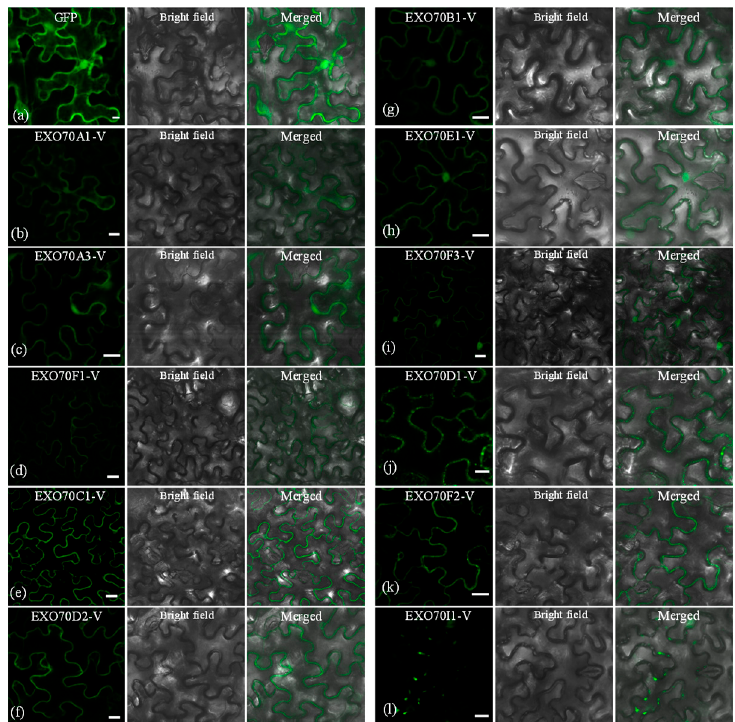
Figure 7. Subcellular localization of H. villosa EXO70-GFP-Vs proteins. H. villosa EXO70-GFP-Vs proteins were transiently expressed in N. benthamiana leaves carried out with injection of Agrobacterium and examined by a confocal microscope. Green fluorescence was observed 48 h after infection. Bar = 20 µ m. ( a ) The empty GFP vector was used as the control. The green channel shows that GFP signals were localized in the nucleus and cytoplasmic and plasma membranes. ( b – l ) The subcellular localization pattern of EXO70A1-V to EXO70I1-V, respectively.